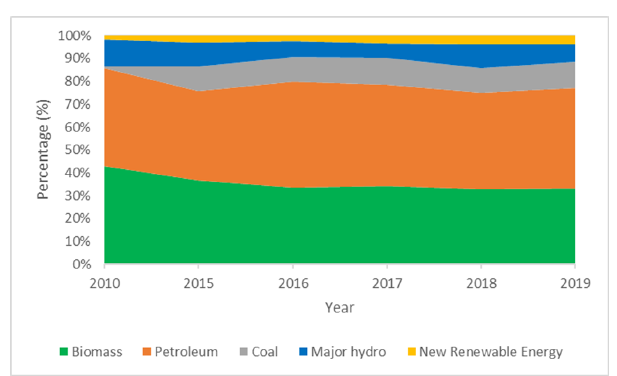
Energies 2022 , 15 , x FOR PEER REVIEW Figure A1. Percentage share of primary energy supply adopted from [1]. Figure A1. Percentage share of primary energy supply adopted from [1].